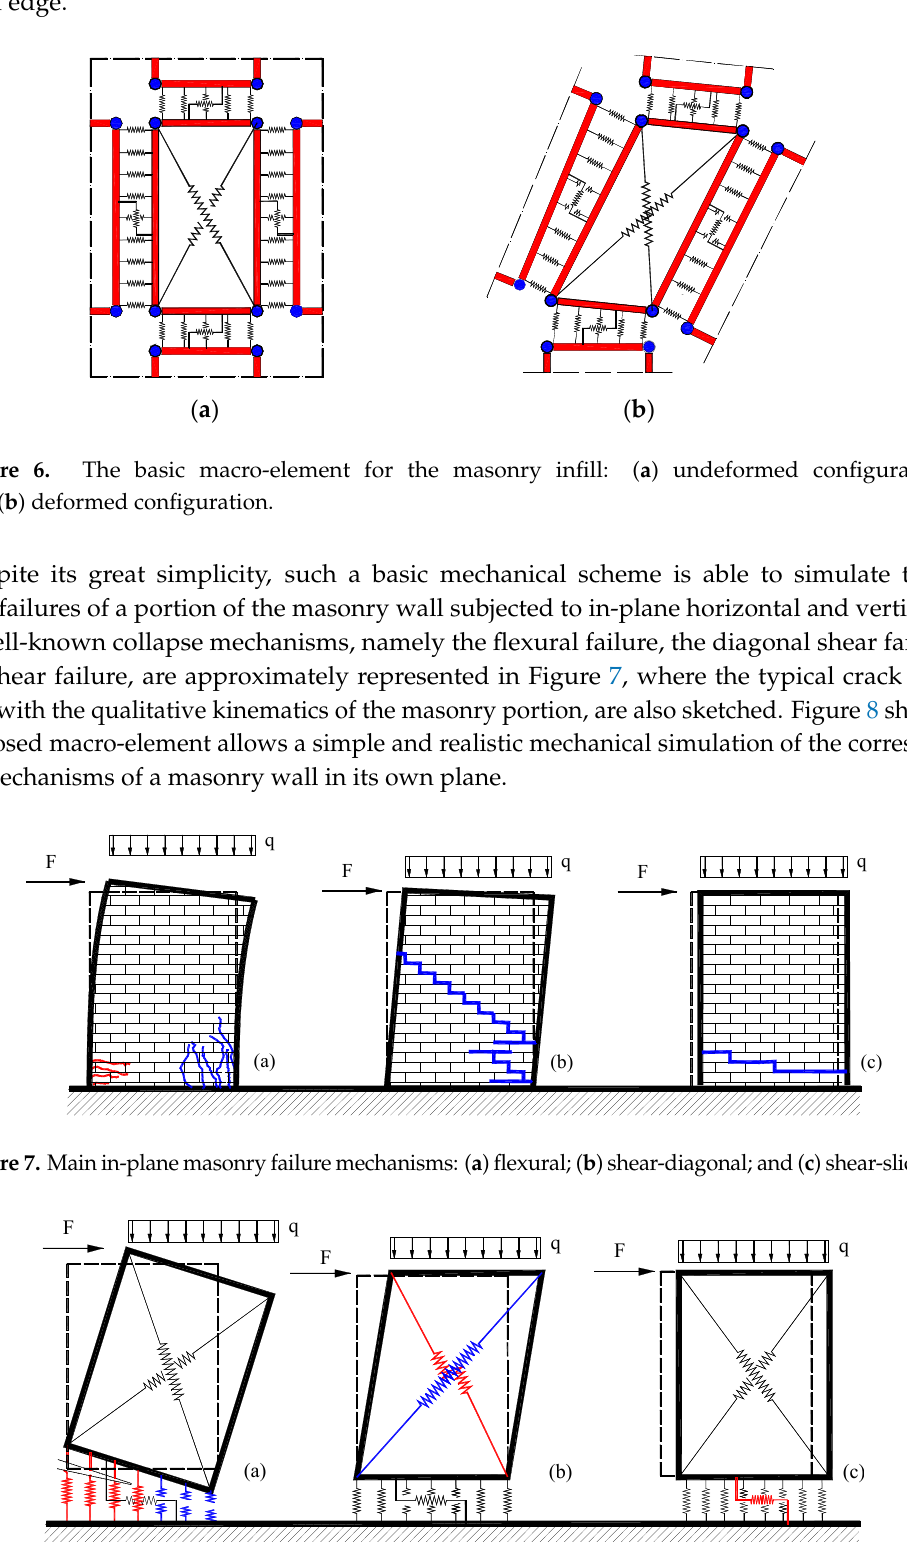
Figure 8. Simulation of a masonry portion collapse mechanisms by means of the macro-element of the in-plane mechanisms: ( a ) flexural; ( b ) shear-diagonal; and ( c ) shear sliding.